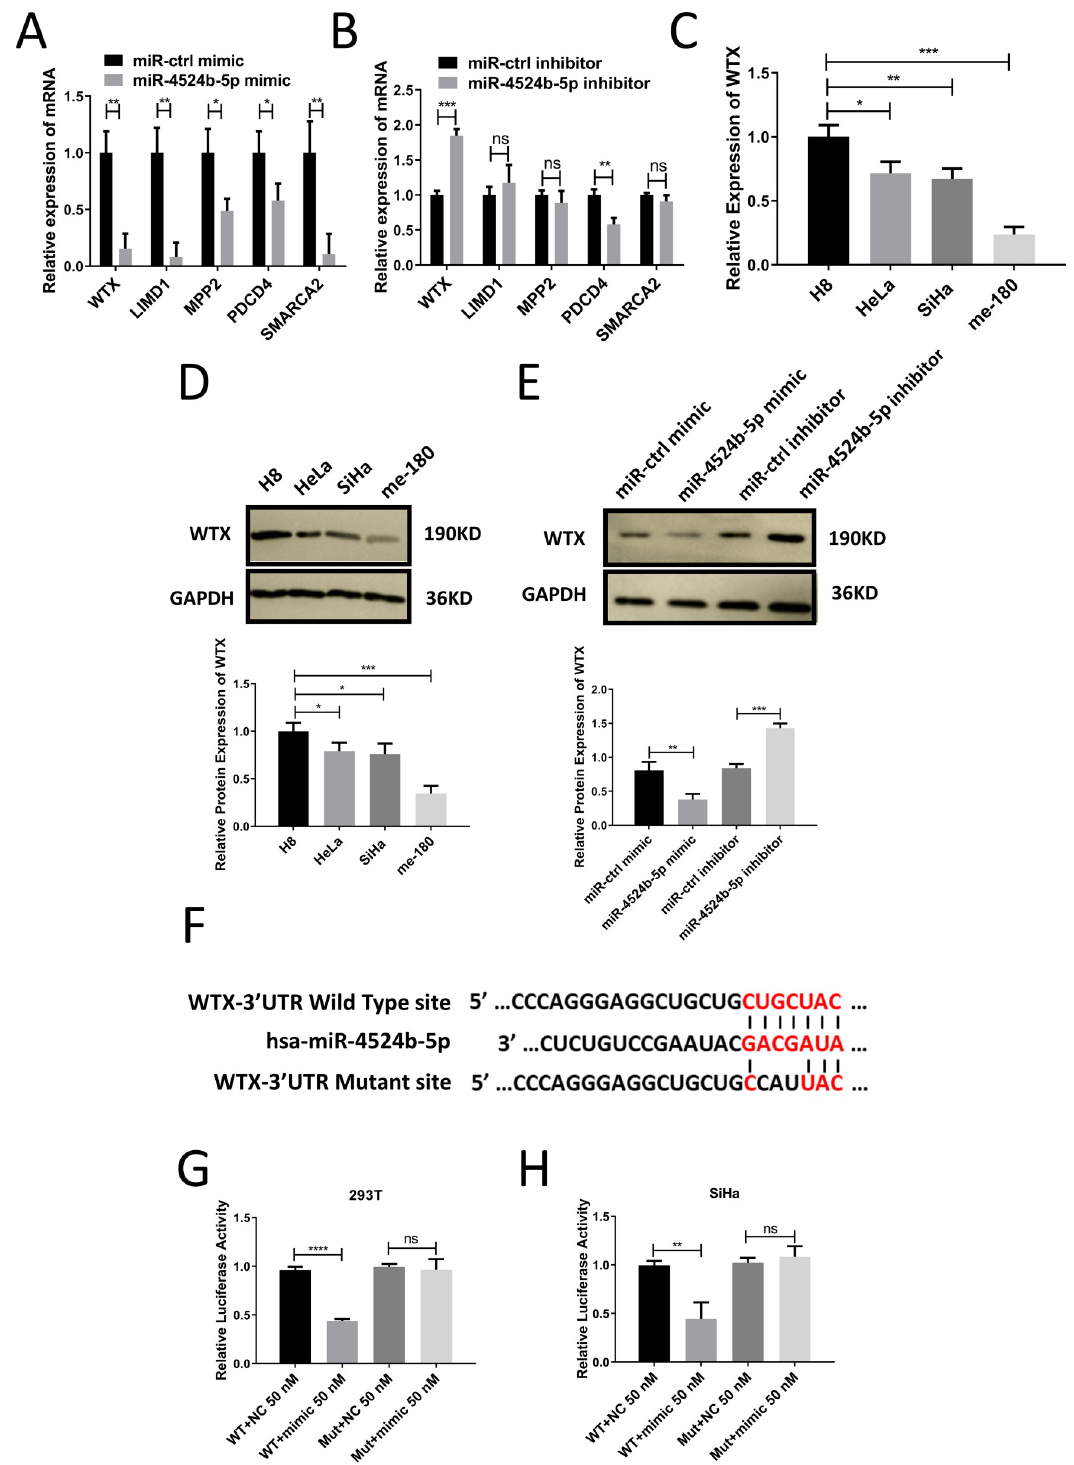
Fig 4. MiR-4524b-5p downregulated WTX mRNA and protein levels by directly targeting the 3’UTR of WTX. (A) Relative expression of five potential gene mRNAs in SiHa transfected with miR-4524b-5p mimic or miR-control mimic. (B) Relative expression of five potential gene mRNAs in SiHa transfected with miR-4524b-5p inhibitor or miR-control inhibitor. (C) Relative mRNA expression of WTX in cervical cancer cell lines and normal cell lines. (D) Relative protein expression of WTX in cervical cancer cell lines and normal cell lines. (E) Western blot analysis of the effects of miR-4524b-5p overexpression and inhibition on